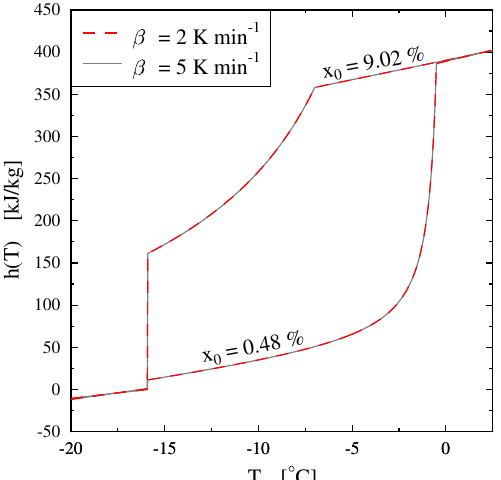
Figure 34. Estimated specific enthalpie of H 2 O/NH 4 Cl solution for two composition and to heating rates